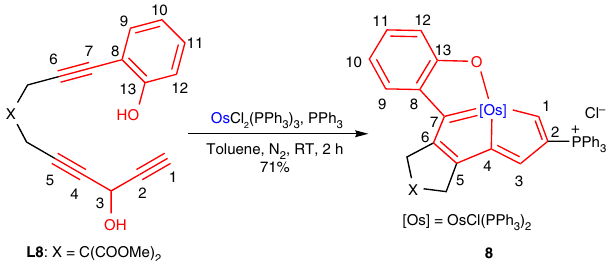
Fig. 5 Synthesis of CCCO-type chelate from a phenolic group substituted triyne. Phenolic group substituted triyne as ligand precursor to access CCCO-type